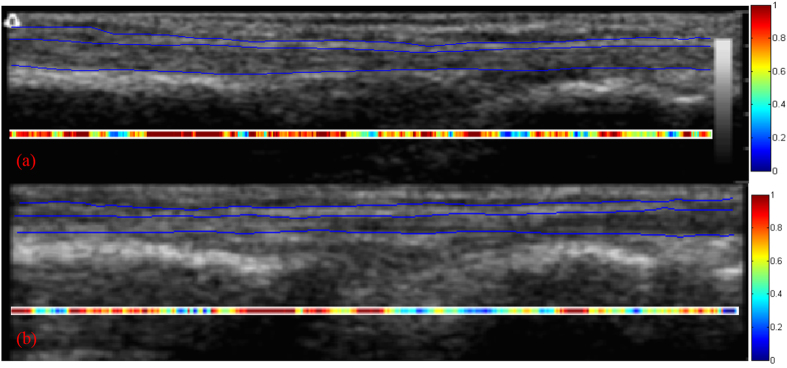
Ultrasound image of the EDC tendon and its surrounding tissue from the first (a) and second (b) measurements of a patient. The marked difference between the two adhesion images illustrates the improvement after rehabilitation.